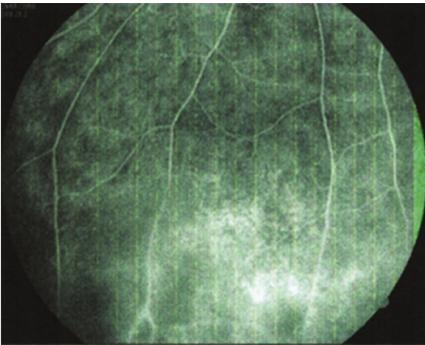
Figure 1: Behcet’s disease, retinal periphlebitis.